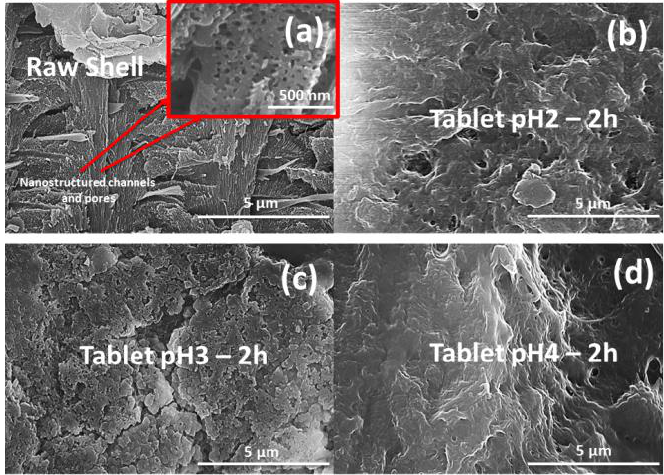
Figure 4. Scanning electron microscopy (SEM) image of the raw biogenic fragments of blue crab shells ( a ) compared to the tablet exposed to acidic pH: pH 2 ( b ), pH 3 ( c ), and pH 4 ( d ).